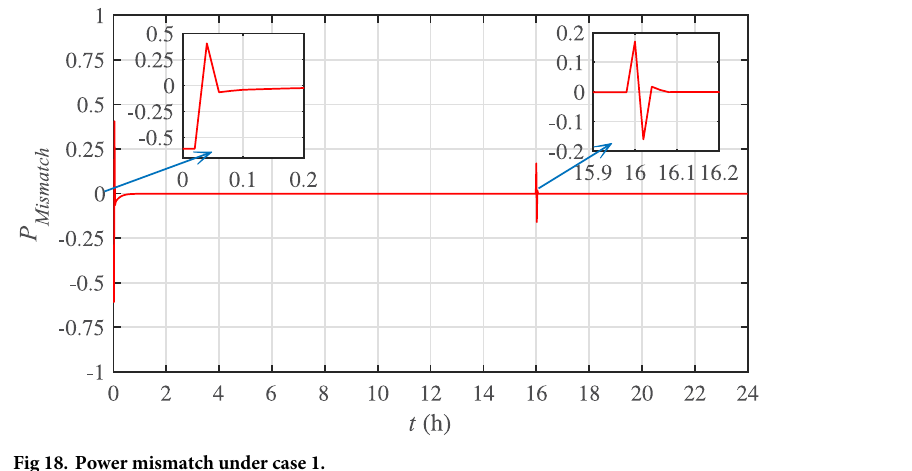
Fig 18. Power mismatch under case 1.